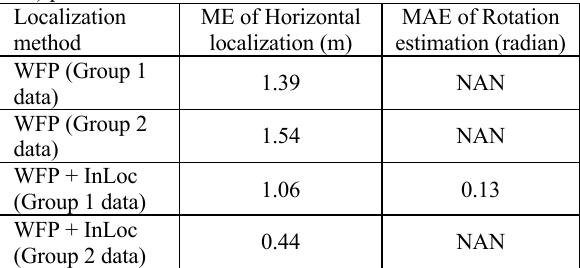
Table 3. Mean absolute error of rotation and mean error of horizontal localization estimation with different positioning methods and test datasets.